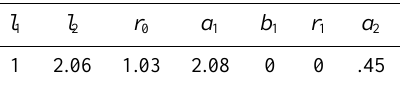
Table 1. Da Vinci’s two-phalanx mechanism geometric